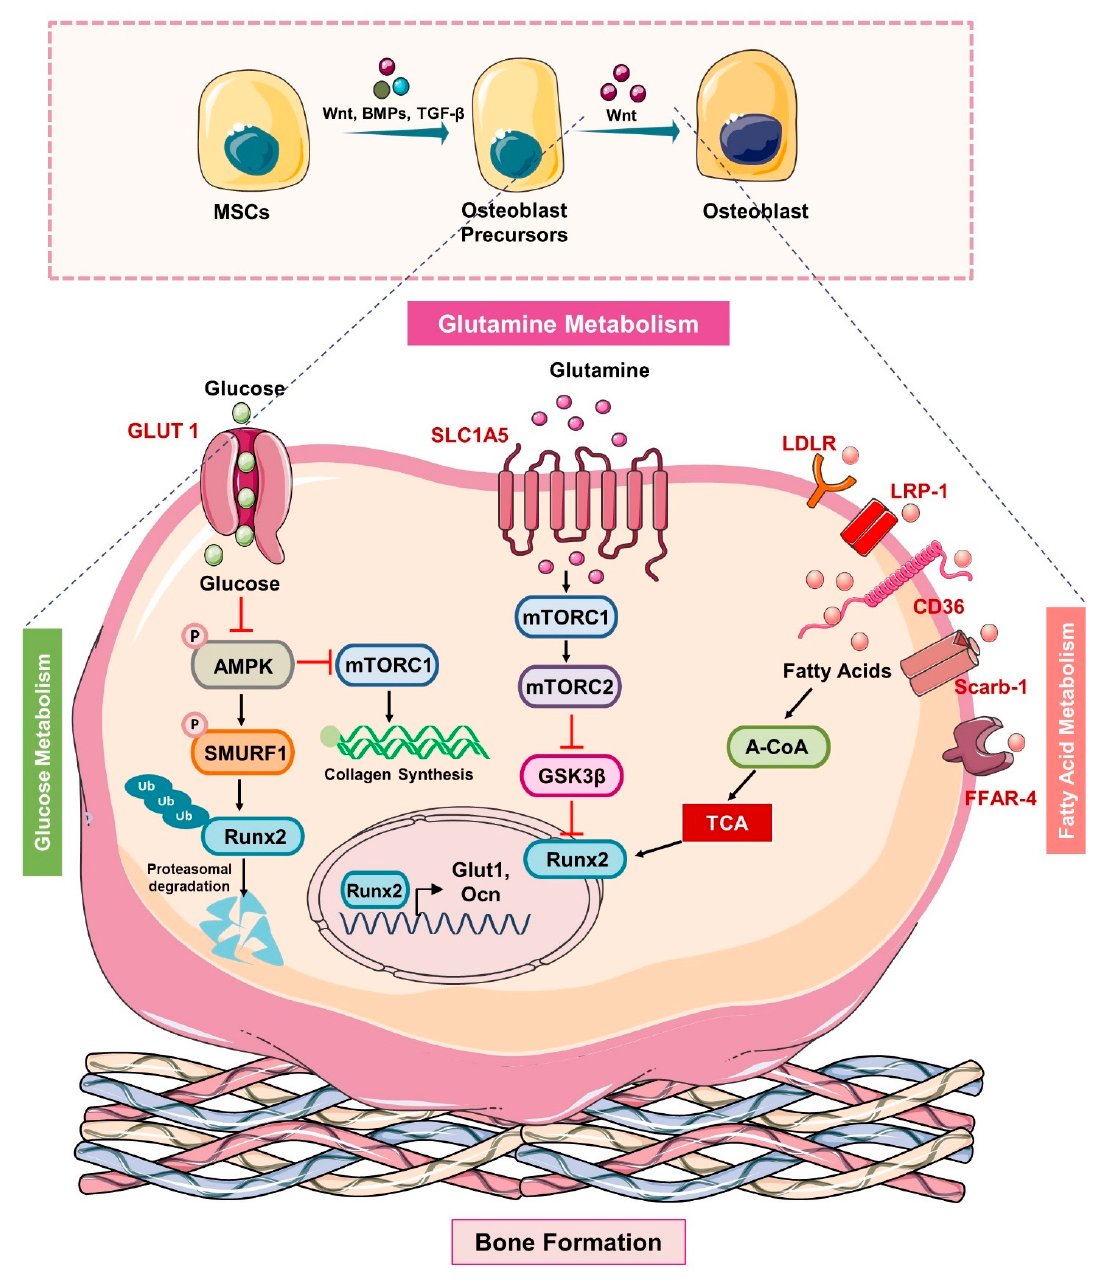
Figure 2. Metabolic pathways in Osteoblasts: In response to the Wnt ligand, BMPs and TGF β , MSCs differentiate into mature osteoblasts. Glut1 controls the uptake of glucose in osteoblast pre- cursors that via inhibiting the phosphorylation of AMP-activated protein kinase (AMPK) suppress the phosphorylation of E3 ubiquitin ligase (SMURF1) that in turn reduces the ubiquitination of Runx2 and thus prevents the proteasomal degradation of Runx2. In addition, glucose uptake also activates the mTORC1 and induces the synthesis of collagen. The uptake of glutamine via the SLC1A5 receptor activates mTORC1 which further inhibits GSK3 β by activating the mTORC2 and thus suppresses the degradation of Runx2. In addition, osteoblast precursors express lipid and sol- uble fat receptors such as the low-density lipoprotein receptor (LDLR), LDL receptor-related